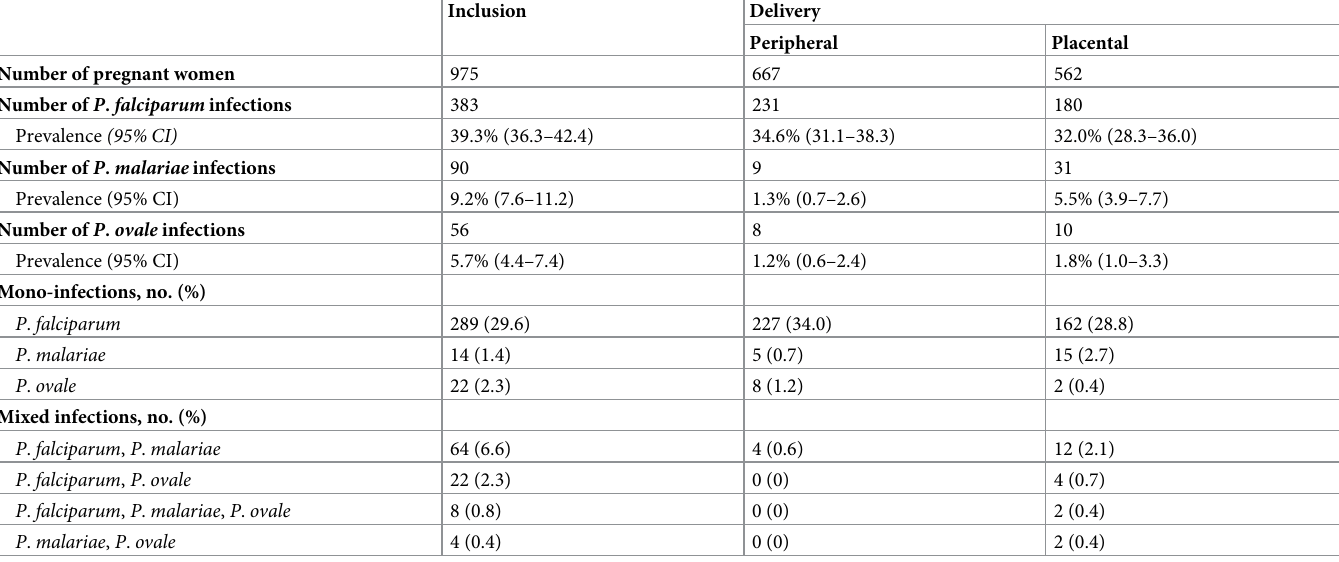
Table 2. Plasmodium spp. infections in Beninese pregnant